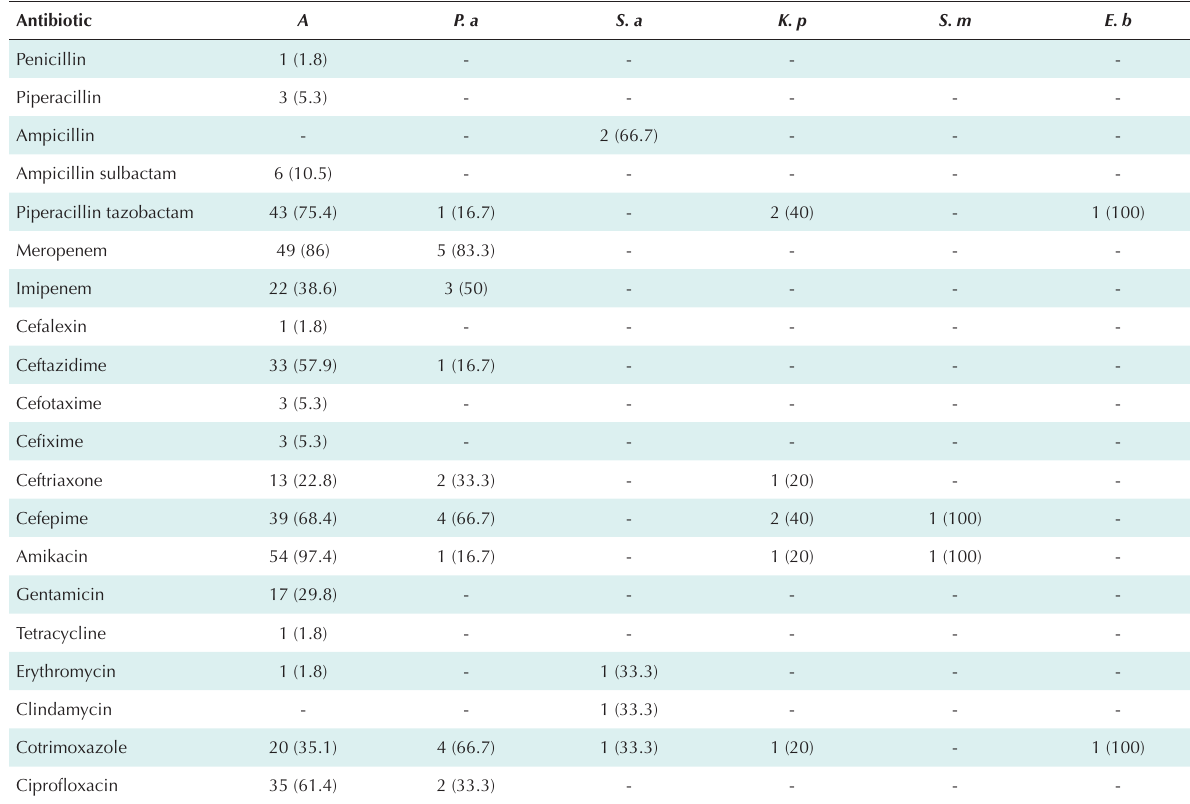
Table 2. Antibiotic Resistance of Isolated Bacteria From the Fifth Day Antibiotic A P. a S. a K. p 1